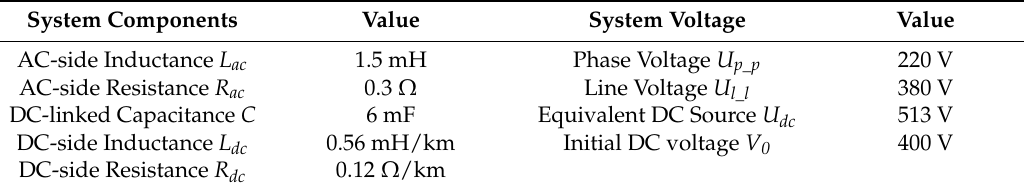
Table 1. Simulation parameters and computed initial